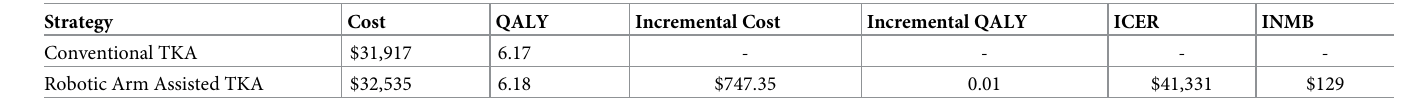
Table 2. Results for base case